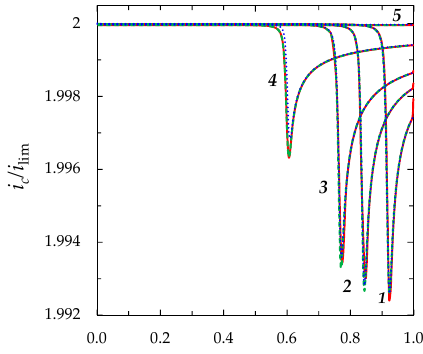
Figure 9. Distribution of current density i c / i lim in the depleted diffusion layer at t = 0.25 (1), 0.3 (2), 0.35 (3), 0.5 (4), 1.5 (5) in the case where a constant current density is set at the left-hand boundary, Equation (27). The red solid line is computed using the “primary” model, the green dashed line, using the “zonal” model; the blue dotted line, using the “simplified” model. ε = 3 × 10 − 7 , i/i lim = 2.